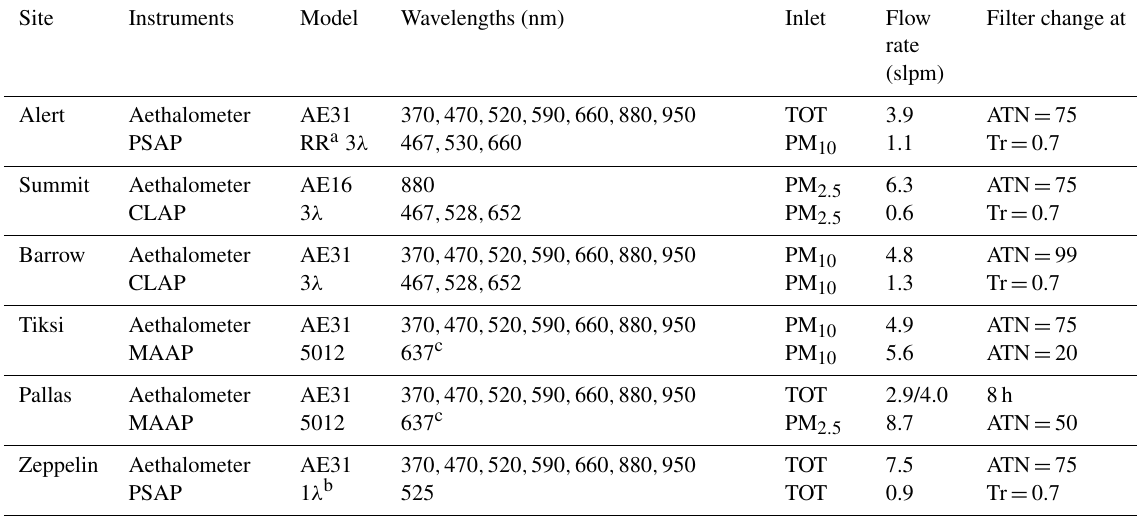
Table 1. Overview of instruments at the respective measurement stations. The flow rates are mean values in standard litres per minute (slpm). TOT means that it is a total aerosol inlet with no cutoff size. Filter change settings reported as either ATN or filter transmittance (Tr). Site Instruments Model Wavelengths (nm) Inlet Flow Filter change